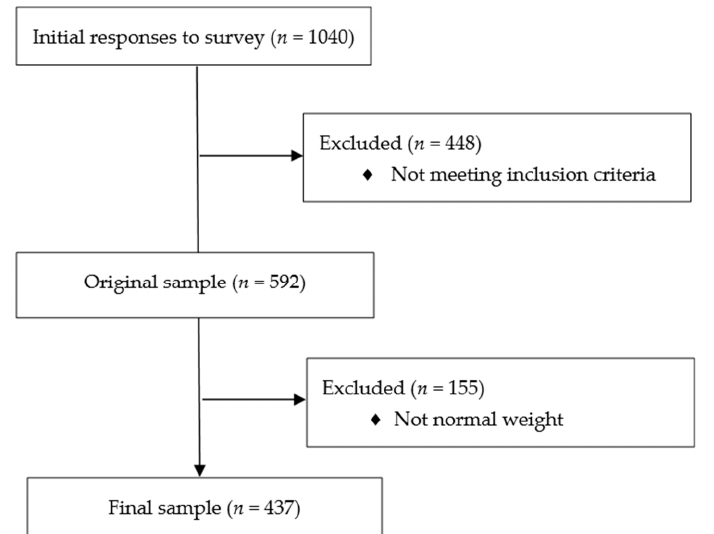
Figure 1. Flow chart. Bivariate correlations revealed that the demographic variables of age and BMI were not significantly correlated with emotional eating. As far as psychological distress is concerned, there was a significant and positive correlation between the total score of DASS-21 (r = 0.395; p < 0.001) and emotional eating. Emotional dysregulation, assessed with the total score of DERS, was significantly and positively associated with emotional eating (r = 0.348; p < 0.001). All correlations are presented in Table 2. Relationships between all the variables of interest.